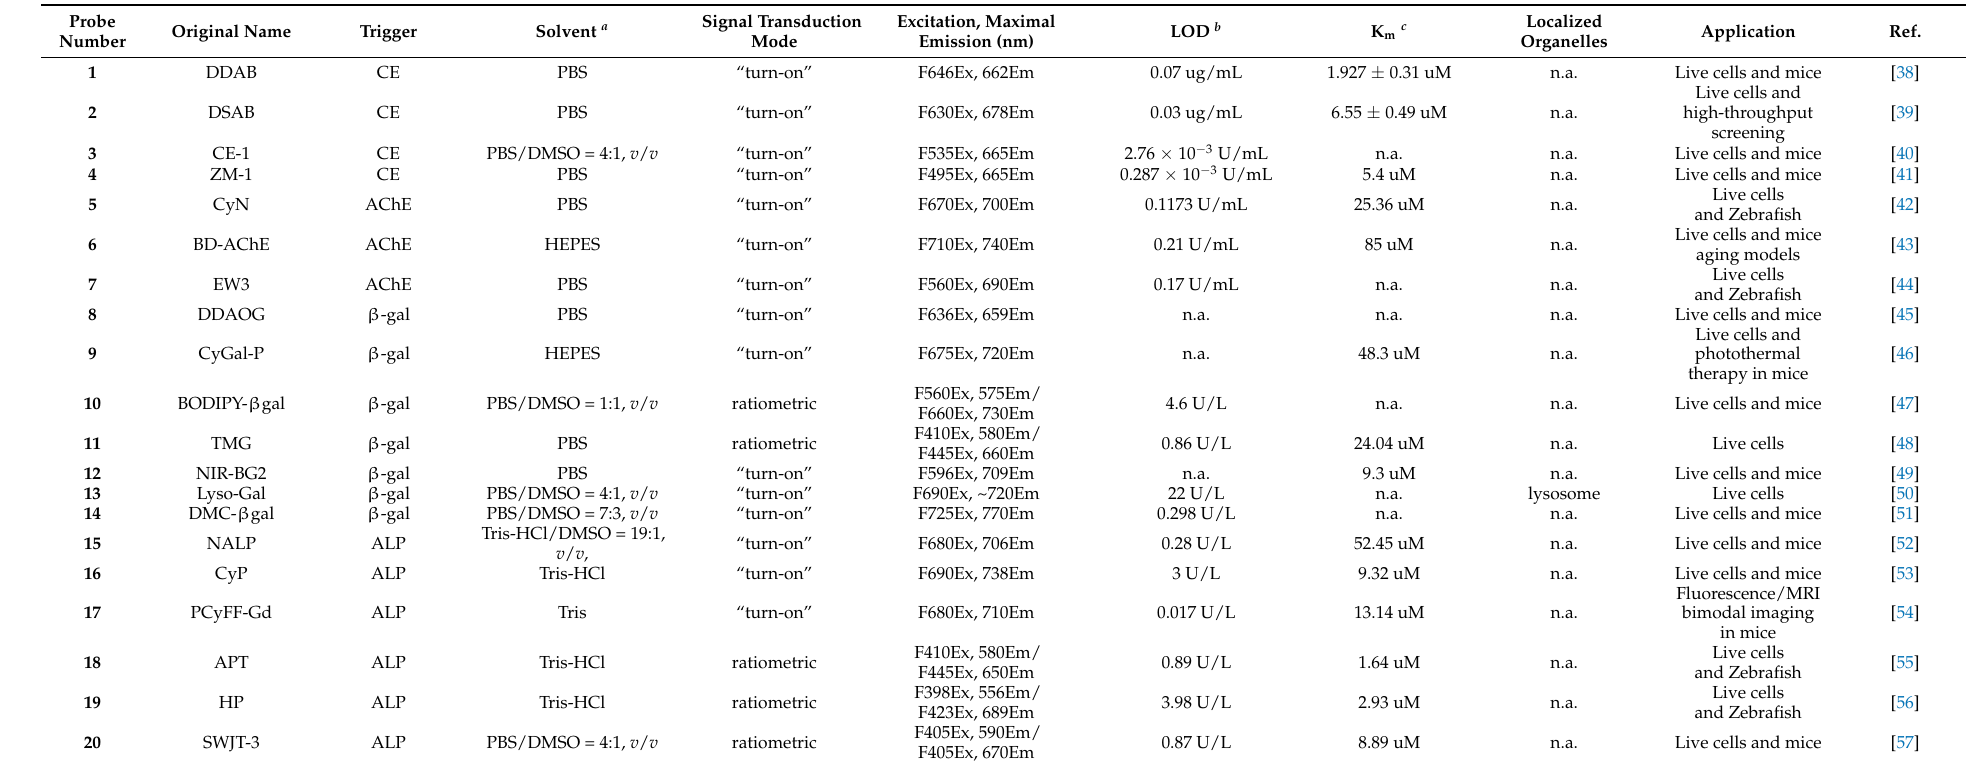
Table 1. Properties of NIR fluorescent Probes 1 − 20